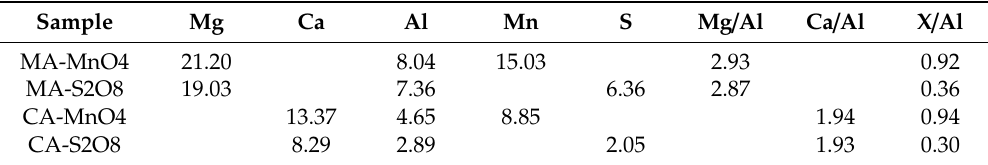
Table 1. Chemical elemental analysis data (% w / w ) of the synthesised samples and calculated molar ratios. All values rounded to two decimal